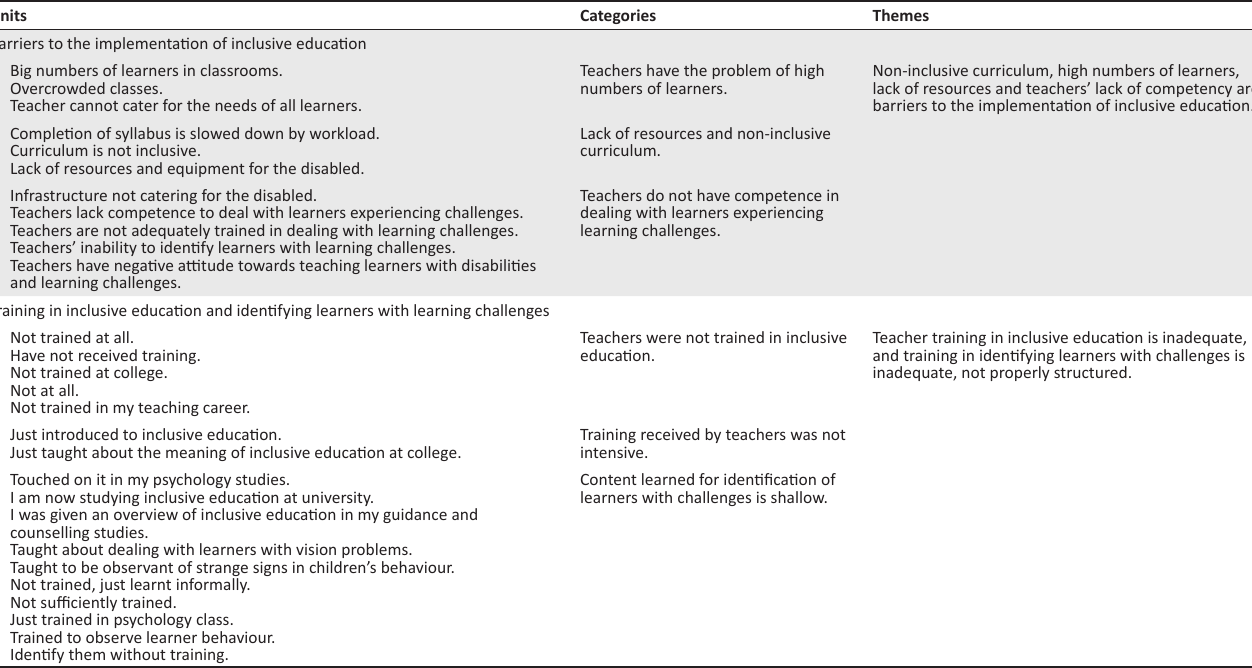
TABLE 3: Units, categories and themes that emerged during data analysis.